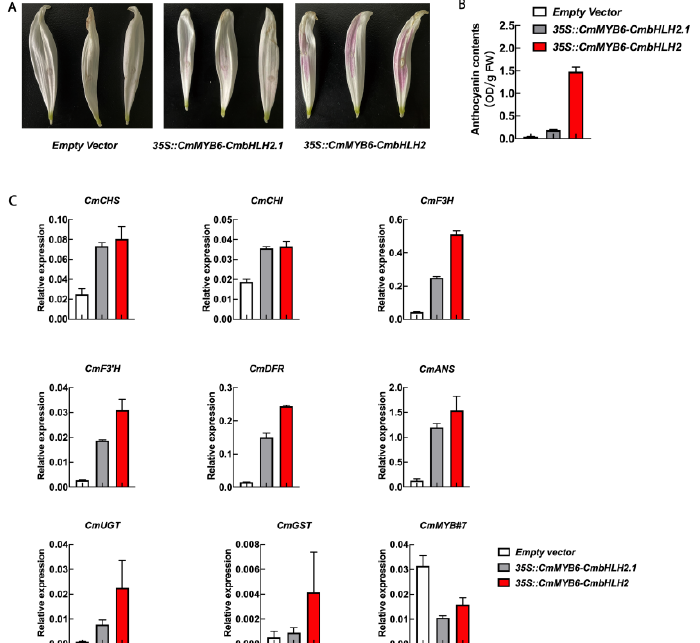
Figure 7. Transiently over-expressed CmMYB6 together with CmbHLH2 and CmbHLH2.1 in white ‘Jimba’. ( A ) The flower petals infiltrated with Empty vectors, 35S::CmMYB6-CmbHLH2 and 35S::CmMYB6-CmbHLH2.1 . ( B ) Relative anthocyanin contents of transformed patches. ( C ) Relative expression of anthocyanin structural genes and regulators. Error bar indicated the SE of three independent biological replicates.